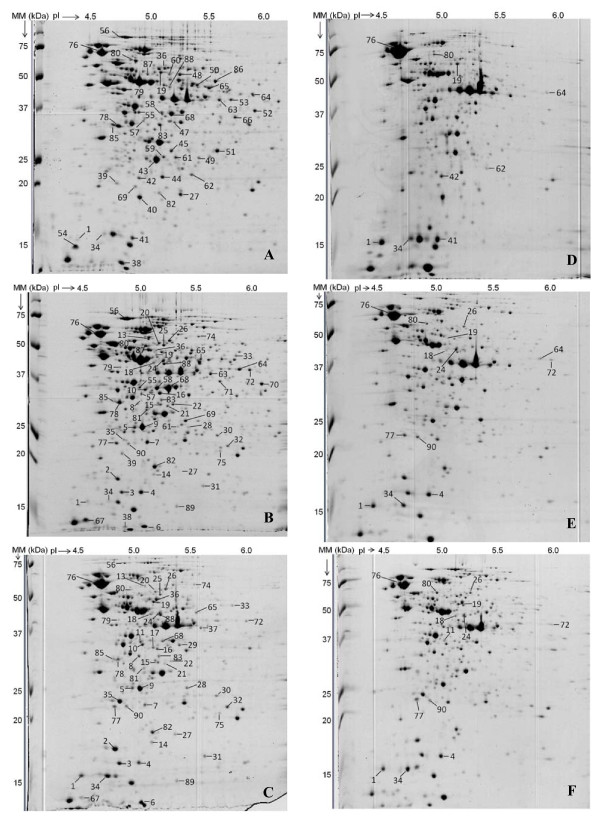
2-DE gels of whole cell proteomes from L. plantarum LC 56, LC 804 and 299 V cultured in standard and bile-stressing conditions. The figure shows representative 2-DE gel pictures (pH range: 4-7) of whole-cell protein lysates from early stationary phase of L. plantarum LC 56 (A and D), LC 804 (B and E), and 299 V (C and F) cultured without (A-C) and with (D-F) 3.6% (w/v) Oxgall. Spots exhibiting differential expression between strains in standard growth conditions and identified by LC-MS analysis are labeled (A-C), with a focus on expression changes after bile exposure for proteins previously reported as being involved in bile tolerance processes (D-F).